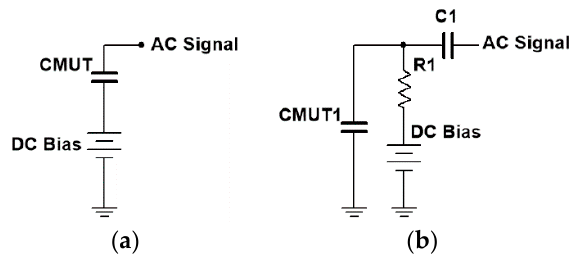
Figure 3. Two forms of the bias-tee design: ( a ) load DC bias and AC signals on different plates of the capacitive micromachined ultrasonic transducer (CMUT); ( b ) load DC bias and AC signals on the same plate of the CMUT.